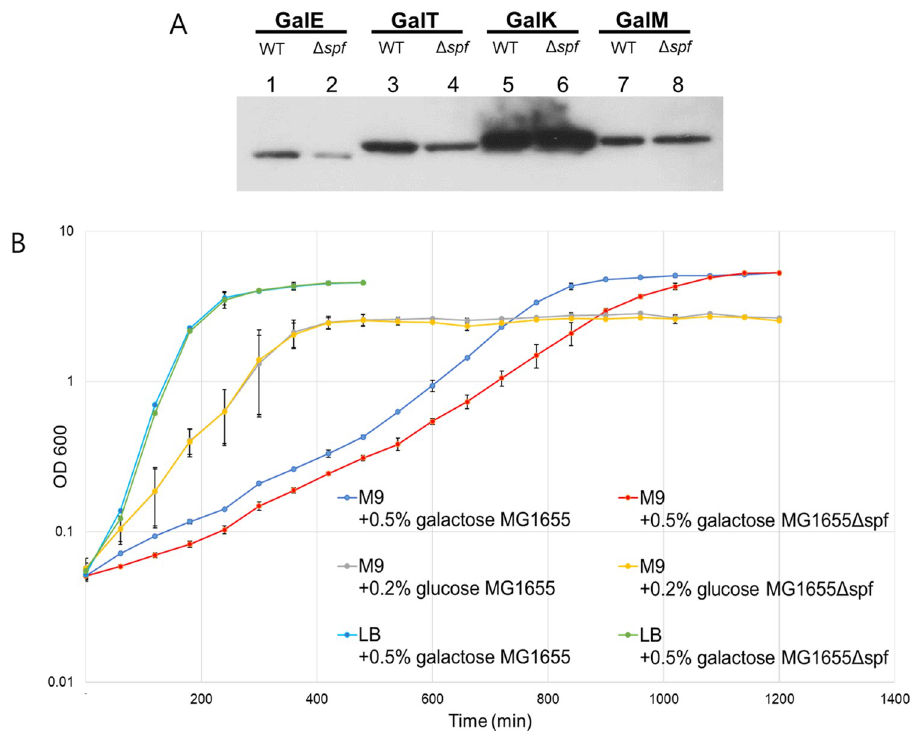
Fig 6. Spot 42 regulates the tuning of gal protein levels towards an anabolic pathway. A) Western blot analysis of the protein products of gal operon (GalE, GalT, GalK and GalM) from WT and Δ spf cells. B) Physiological effect of Spot 42 deletion. This was measured by comparing growth rate of MG1655 and MG1655 Δ spf cells in various media: LB with 0.5% galactose (light blue and green), M9 with 0.2% glucose (grey and yellow) and M9 with 0.5% galactose (blue and red). The growth of MG1655 Δ spf cells was identical to that of MG1655 in LB-galactose and M9-glucose media. In M9-galactose medium, MG1655 Δ spf cells (red) showed slower growth than that of MG1655 cells (blue). Error bars represents the mean fold-change ± standard deviation of three replicates from three independent experiments (n =